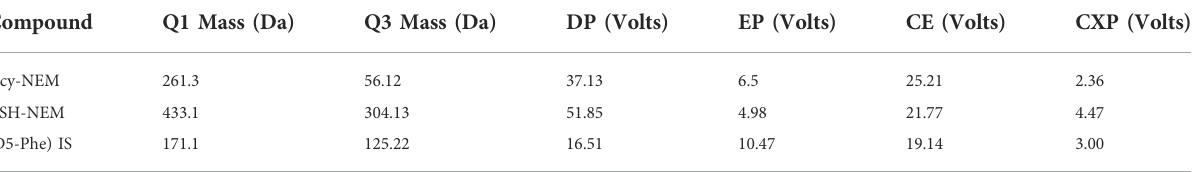
TABLE 2 Mass spectrometric characteristics of GSH and Hcy.